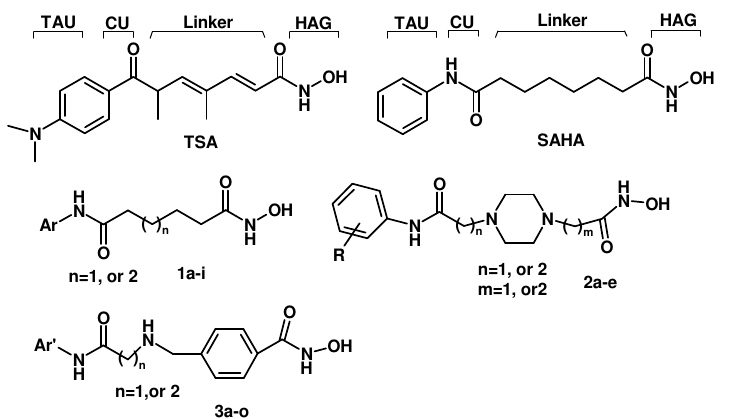
Figure 1. Structures of TSA, SAHA and designed